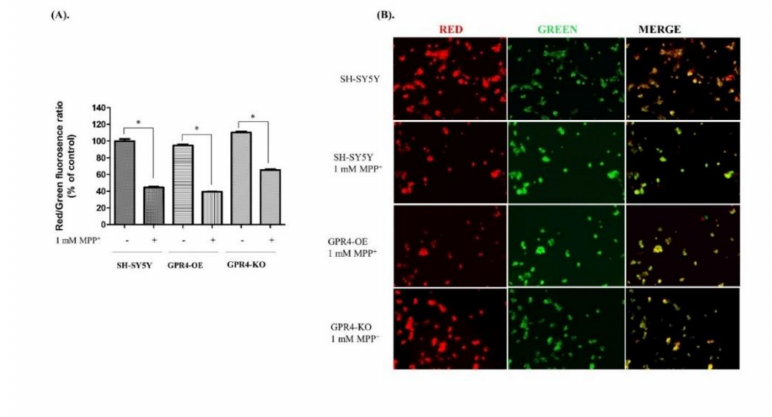
Figure 7. The measurement of mitochondrial membrane potential (MMP) in MPP + -treated SH-SY5Y cells that were stably GPR4-OE or GPR4-GPR4-KO. 24 h serum-starved SH-SY5Y cells were treated with MPP + (1 mM) for 24 h in serum-free culture media; a JC-10 fluorescence quantitative assay (according